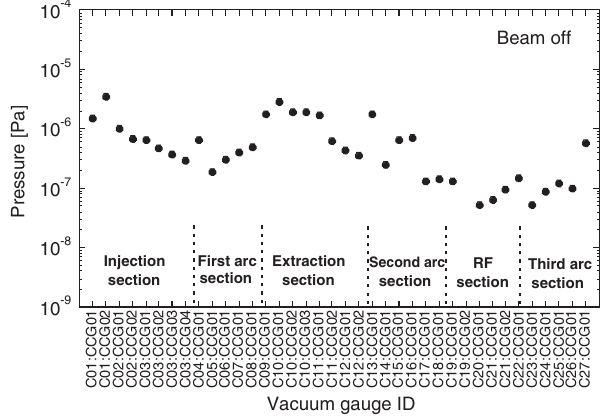
FIG. 2. Typical example of the beam line pressure distribution in the RCS. The pressure at about one month from the start of evacuation after the vacuum system shutdown.